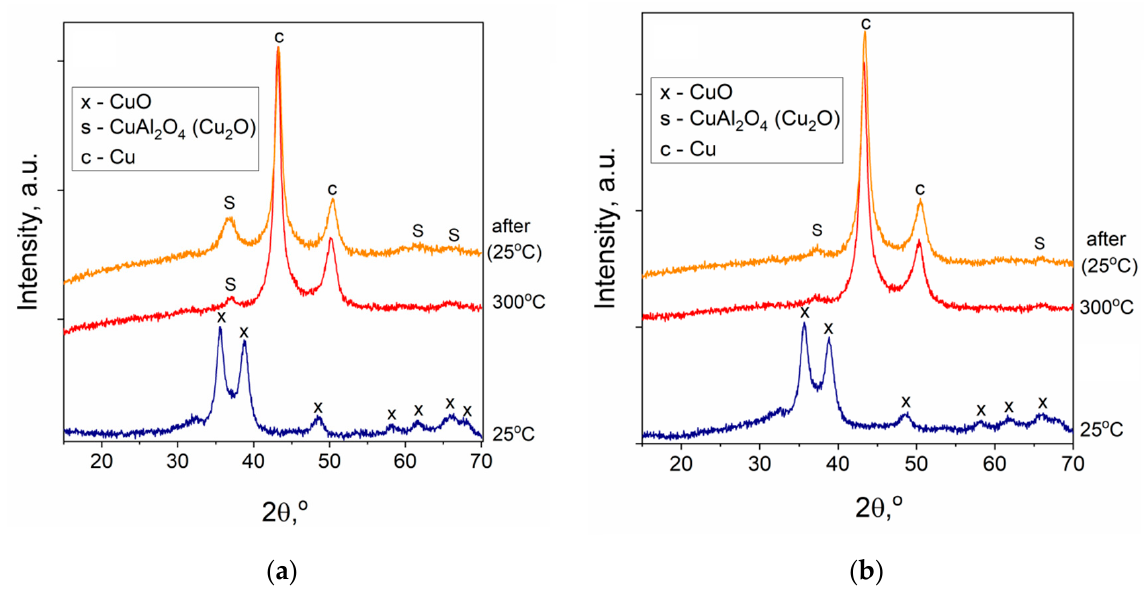
Figure 3. XRD patterns of ( a ) CuAl-LDH-1h and ( b ) CuAl-LDH-2h reduced in situ in H 2 /He flow.